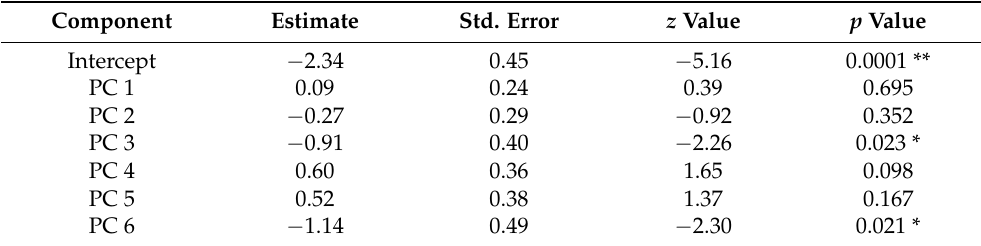
Table 8. Logistic regression estimates between the classifications components of N . elegantalis females–host plant and the size of the Principal Component structures.